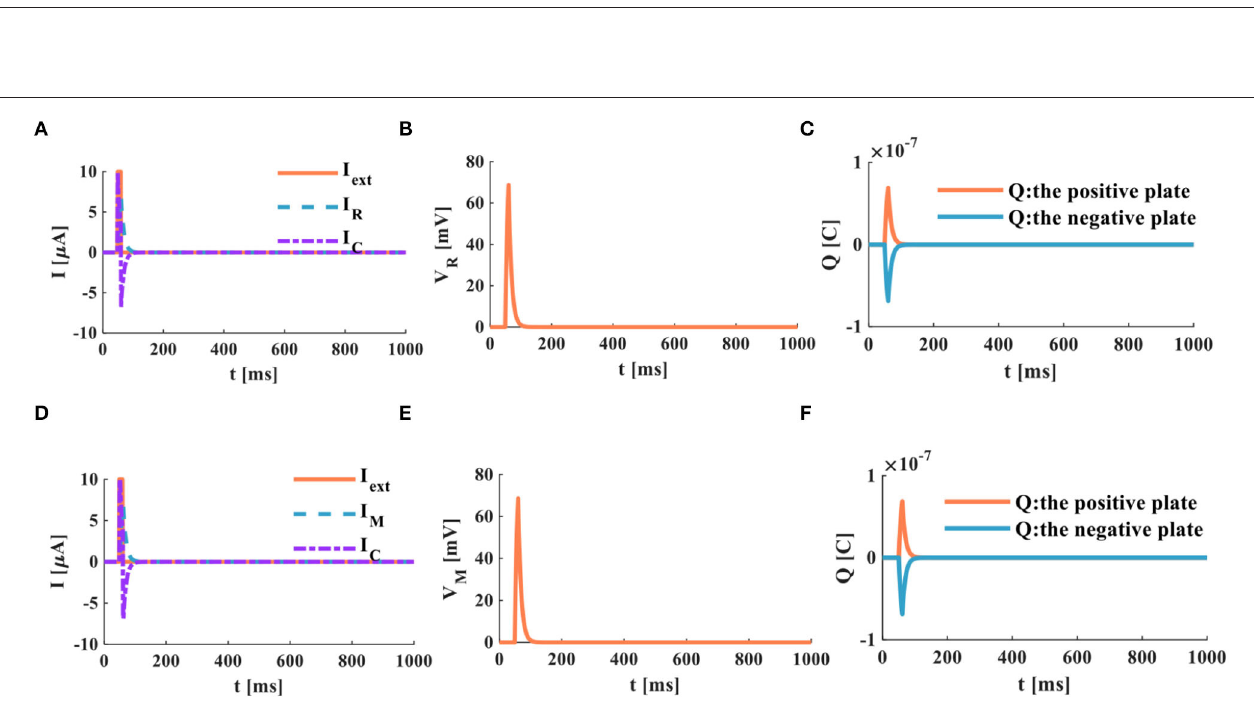
FIGURE 14 | A single pulse acts on the RC and the MC neuron circuits, (A) the current flows through the resistor R and the capacitor C, (B) the membrane potential of the RC circuit, (C) the charges on the positive and negative plates in the RC circuit, (D) the current flows through the memristor M and the capacitor C, (E) the membrane potential of the MC circuit, (F) the charges on the positive and negative plates in the MC circuit.